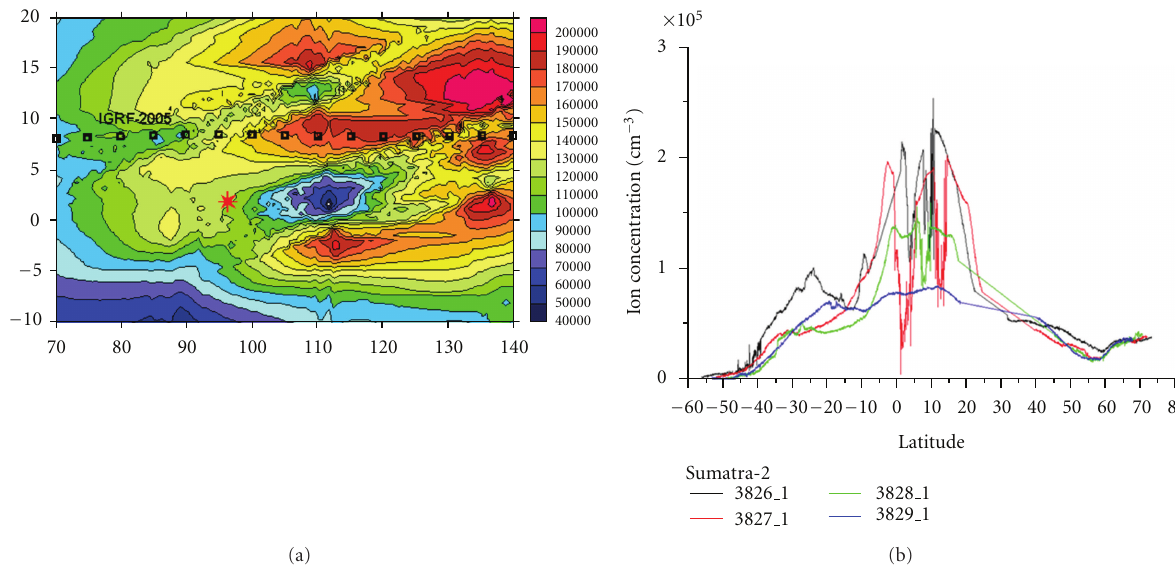
Figure 11: (a): 2D distribution of ion density obtained on board DEMETER satellite over the epicenter of the Sumatra 28 March 2005 M8.7 earthquake obtained for the night-time (22LT) on March 22 2009. (b): the latitudinal variations of the ion density for several night-time passes of DEMTER satellite over the area of preparation of the Sumatra 28 March 2005 M8.7 earthquake during one week before the seismic